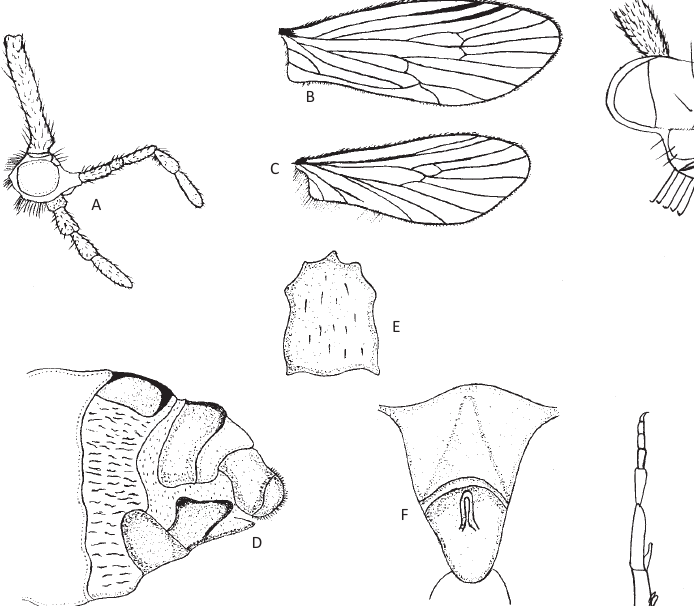
Figure 2. Lepidostoma nuburagangai sp. nov. (female) A - Head, scape and mouthparts, right lateral; B - right fore wing, dorsal; C - right hind wing, dorsal; d - abdominal segments of VIII-X, left lateral; E - subgenital plate, ventral; F - vaginal apparatus, ventral.